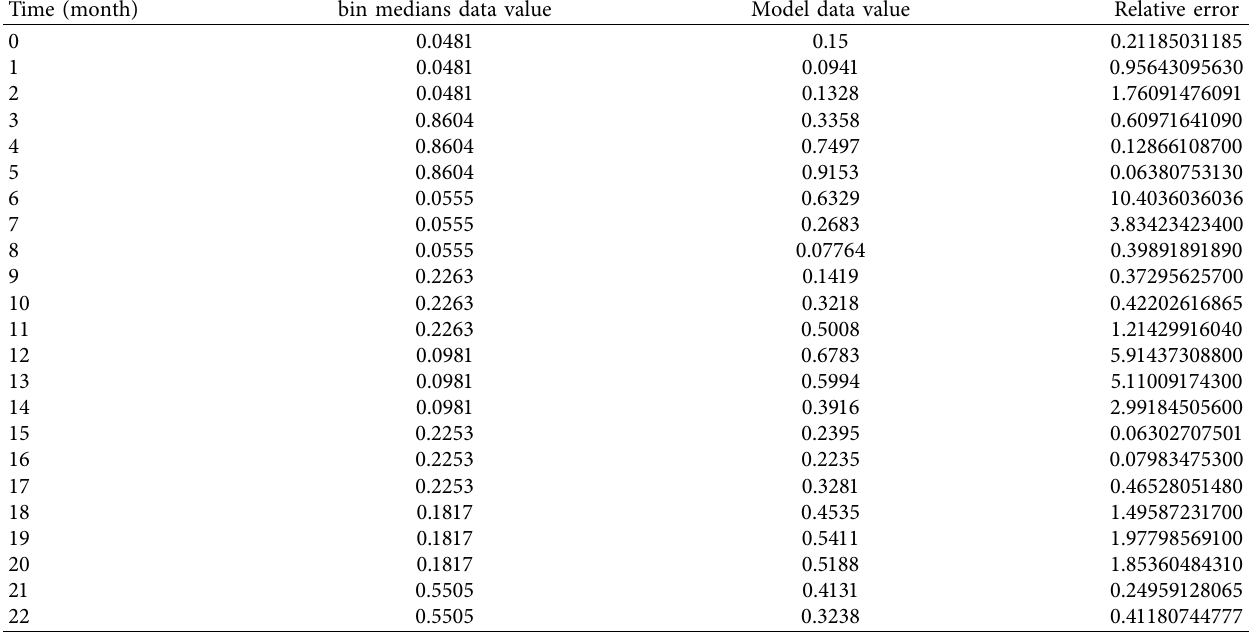
Table 9: Te relative error between the bin medians data and the model